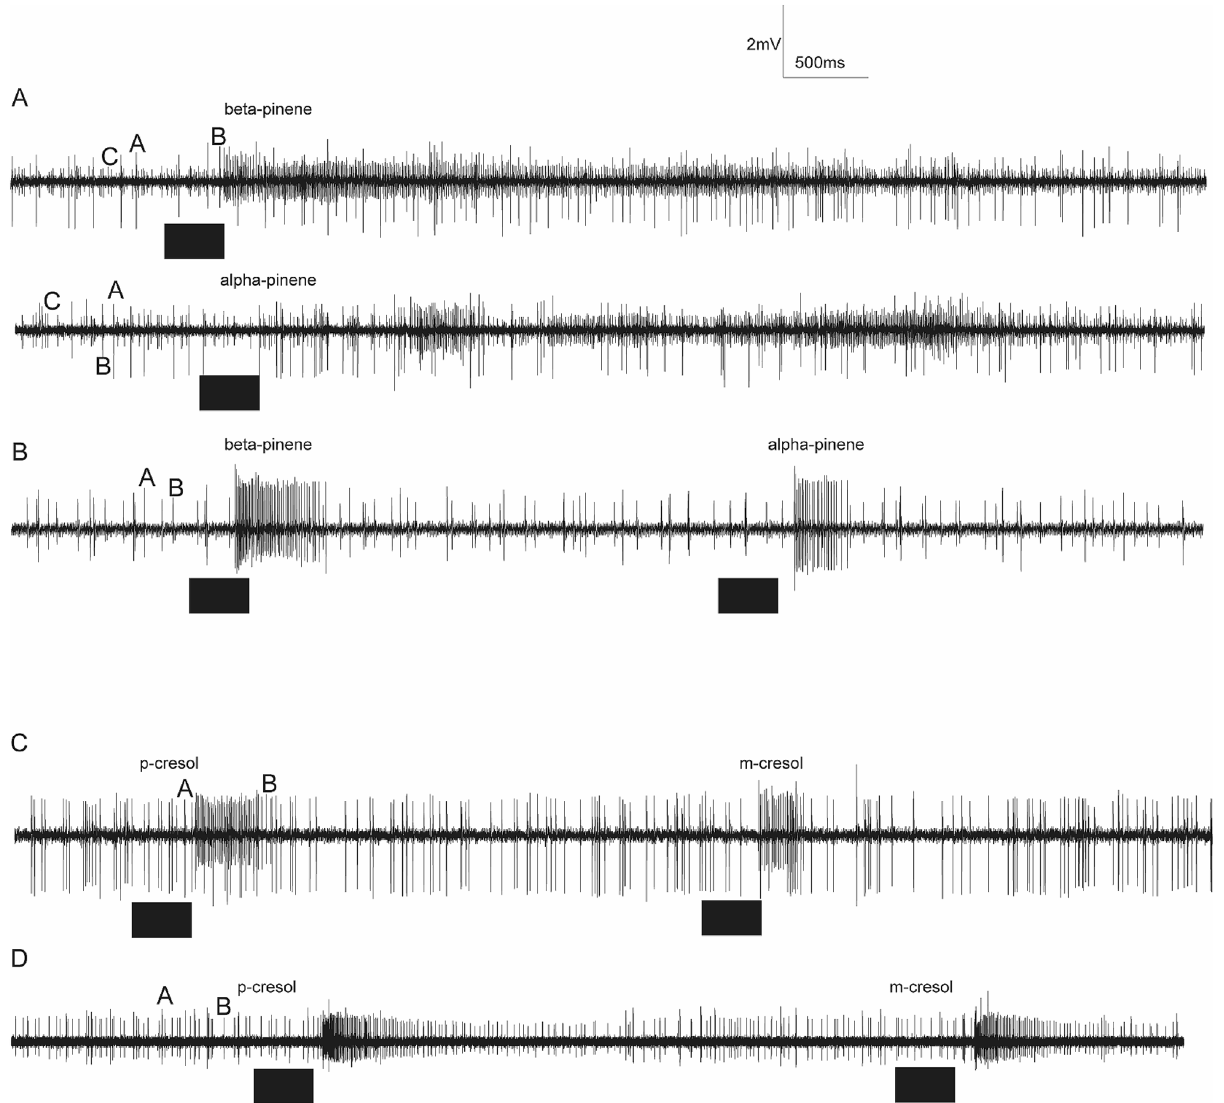
Figure 5. Olfactory coding of isomers by S. calcitrans OSNs. ( A , B ) Representative SSR traces showing OSNs response for α- and β-pinene from Basiconic sensilla. ( A ) Stimulation with α and β-pinene elicits a strong response from the smaller spiking neuron, indicated by ‘C’ whereas the larger spiking neurons, indicated by ‘A’ and ‘B’ are unaffected by the stimulus ( B ) Stimulation with α and β-pinene elicits a response from the bigger spiking neuron, indicated by ‘A’ ( C , D ) representative traces of OSNs response for m- and p -cresol from basiconic sensilla. Stimulation with p-cresol and m-cresol elicits a strong response from the smaller spiking neuron, indicated by ‘B. Horizontal bar indicates stimulus duration, 0.5